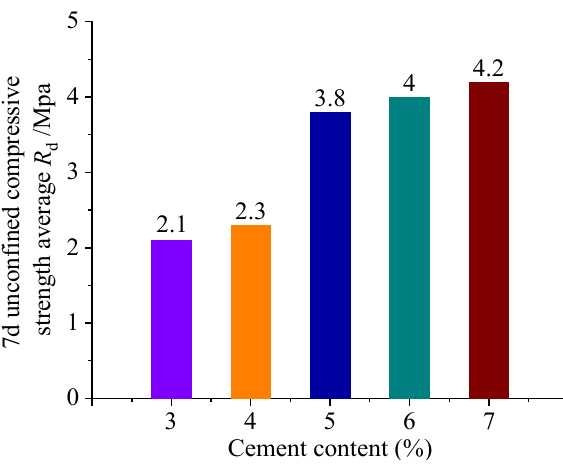
Figure 16. Test results of 7-day unconfined compressive strength. Table 11. 7-day unconfined compressive strength test results of different researchers.